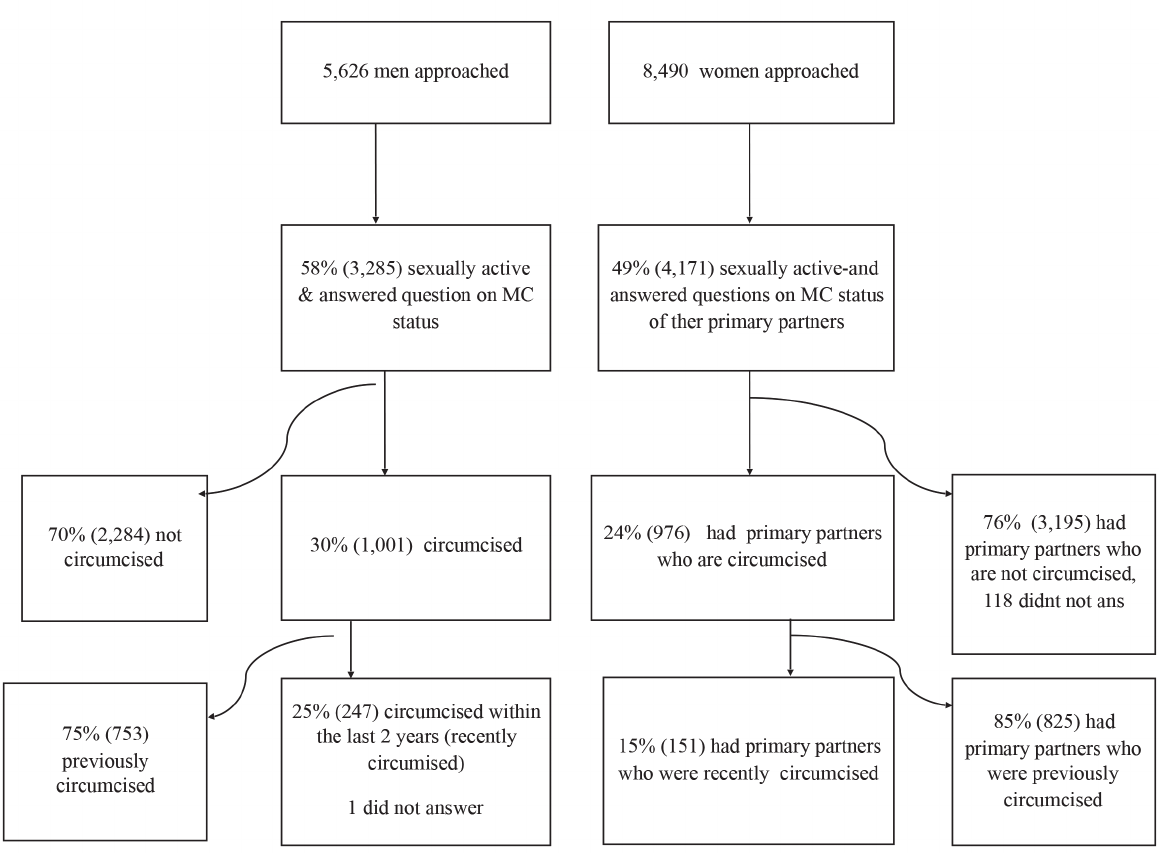
Figure 1. Male and Female Participant Selection by circumcision status (men) or circumcision status of their primary partners (women) in Gem, Siaya County, Western Kenya,